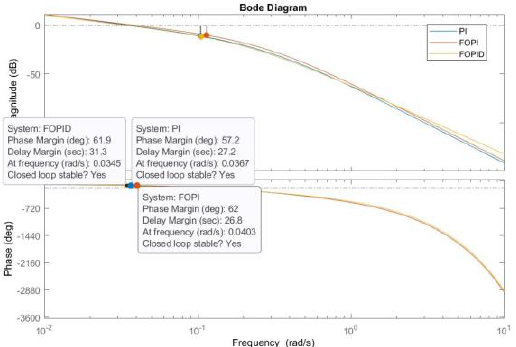
Figure 15. Step responses of closed-loop system for the integer-order PI, FO-PI, and FO-PID con- trollers in the case of −2% process changes.